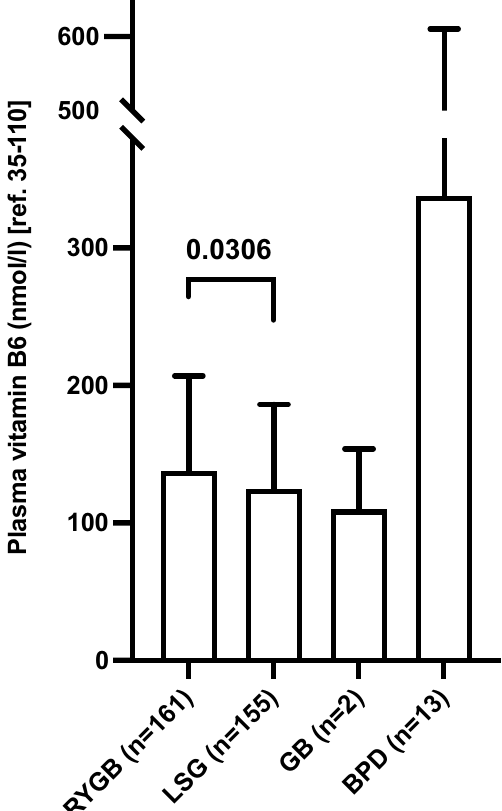
Figure 3. Plasma vitamin B6 levels in patients after different bariatric surgery procedures. Data are presented as median plasma vitamin B6 levels and interquartile range (IQR) for each bariatric surgery procedure. Mean values were 176 nmol/l (IQR 104–205), 161 nmol/l (IQR 87–186), 110 nmol/l (IQR 88–132), and 347 nmol/l (IQR 102–577) in patients with Roux-en-Y gastric bypass (RYGB), laparoscopic sleeve gastrectomy (LSG), gastric banding (GB), and biliopancreatic diversion (BPD). Kruskal–Wallis-Test for intergroup comparison was significant (p-value 0.033). Level of significance between RYGB and LSG was calculated with Mann–Whitney U-test and is indicated in the graph with horizontal bar. Level of significance was not calculated for differences between gastric bypass (GB) or biliopancreatic diversion (BPD) due to low sample size. n number of plasma vitamin B6 measurements in 205 patients in